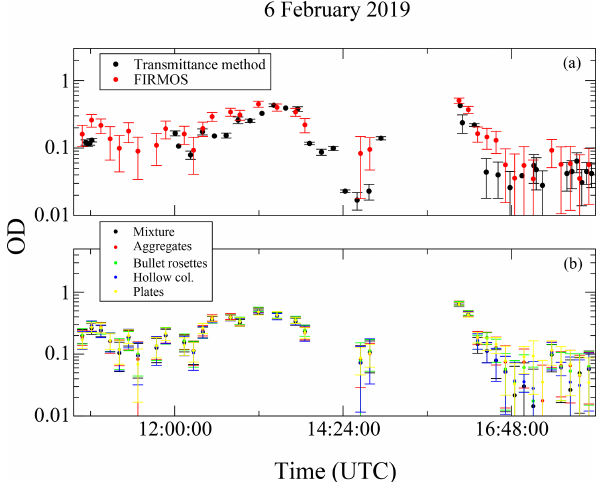
Figure 4. (a) Comparison of the ODs retrieved from FIRMOS data (in red) on 6 February 2019 and those obtained through the trans- mittance method (in black). (b) The retrieved ODs from FIRMOS by assuming the mixture (black) and different ice crystals habits (red, green, blue and